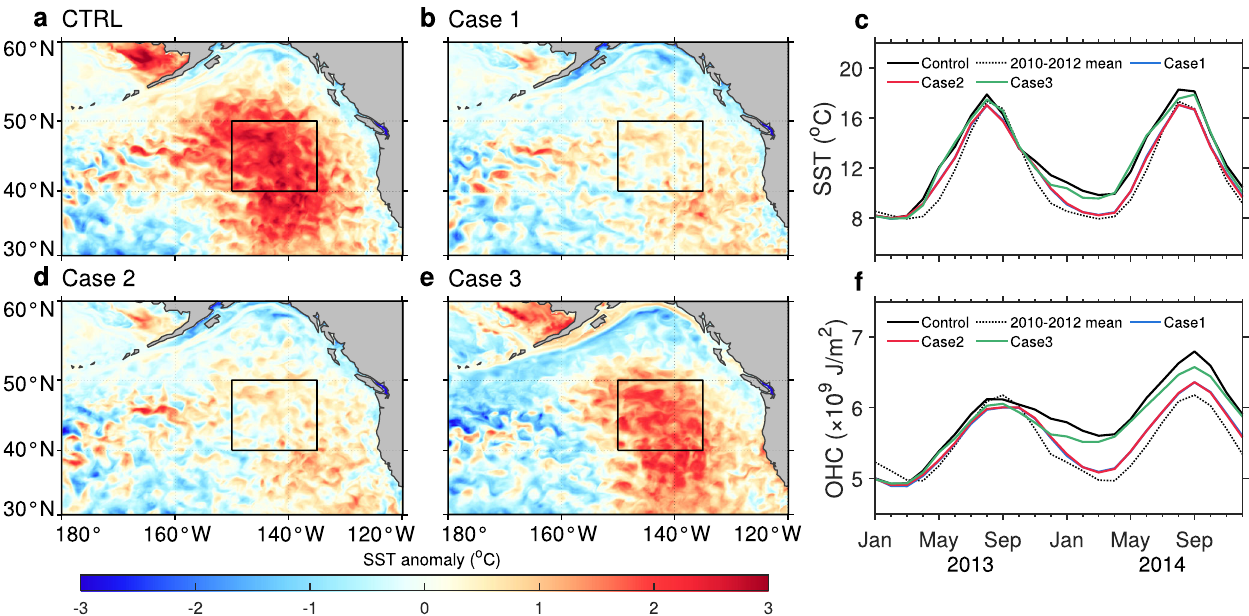
Fig. 6 Anomalous SST fi elds from model outputs. Modeled ( a , b , d , e ) SST anomalies in February 2014 and time series of the ( c ) SST and ( f ) integrated OHC (0 – 150 m) of the model simulations averaged in the black box (40°N – 50°N, 135°W – 150°W) from 2013 to 2014 (solid lines). The dashed lines indicate the normal-year averages (2010 – 2012) of the SST and the integrated OHC (0 – 150 m) in the study